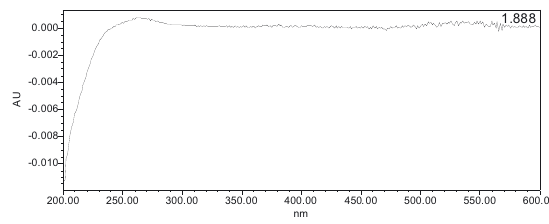
radiation with TiO